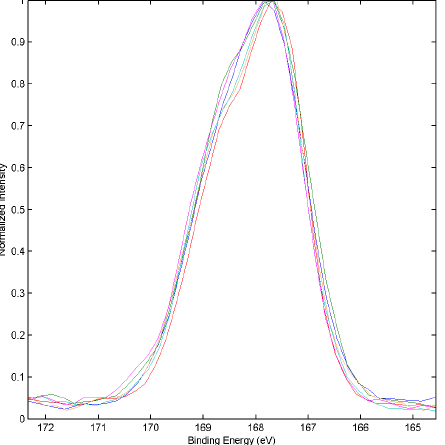
Figure 6. Overlapped S 2p spectra for control and PES samples treated with VUV photo-oxidation for 0, 5, 10, 15, 30, and 60 min. Due to the small changes in S chemical states (Table 3), an arrow indicating increasing treatment time was not possible in this Figure.